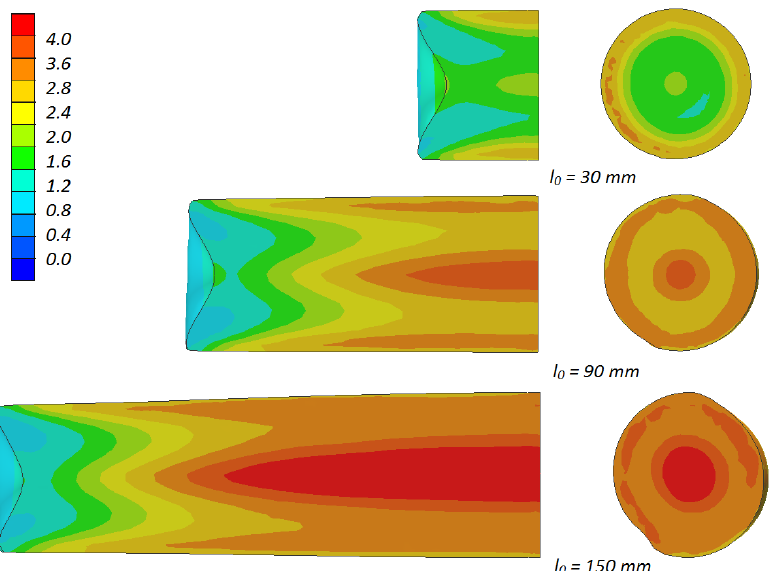
Figure 10. Distributions of effective strain in the samples (with the initial length l 0 ) subjected to rotational compression in the path 315 mm; due to the symmetry of the process ½ samples were shown.